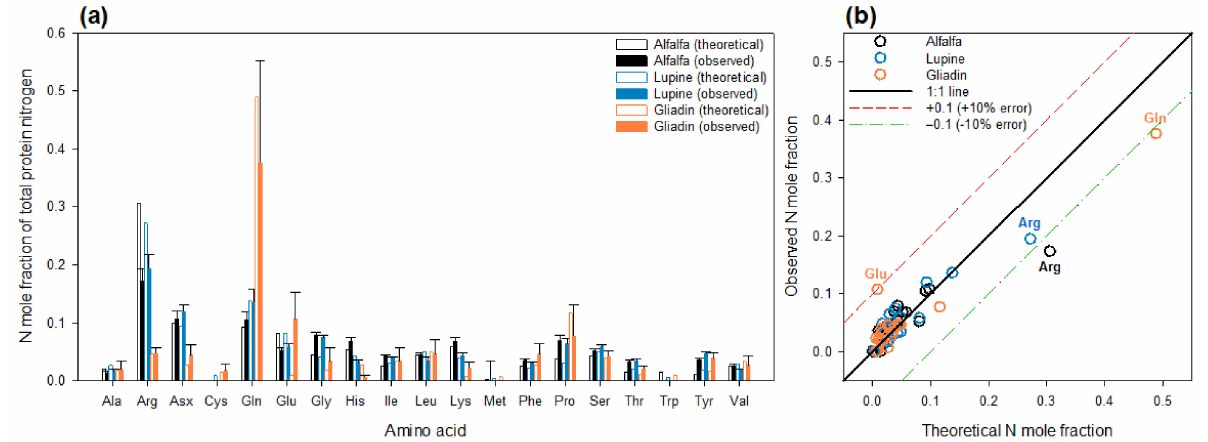
Figure 2. Comparison of theoretical (from protein sequence) and observed (from mass-28 chro- matogram) N mole fraction represented by amino acids. ( a ) Individual comparisons between theory (empty bars) and observations (closed bars). ( b ) Graphical comparisons to show points that are close to the 1:1 line, except for Arg (lupine and alfalfa) and Gln (gliadin). The mole fraction calculated here is the fraction of N represented by the amino acid of interest with respect to total protein N. Due to the production of derivatives, corrections had to be made for some amino acids (see Section